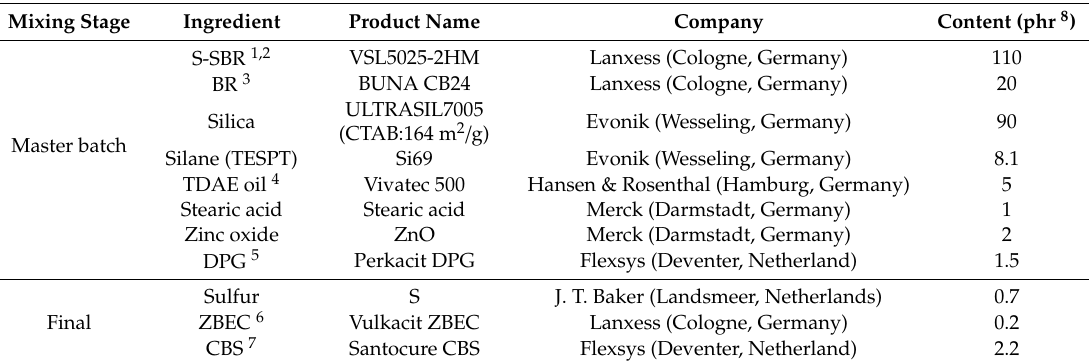
Table 1. Compound formulation. phr, xxxxx.